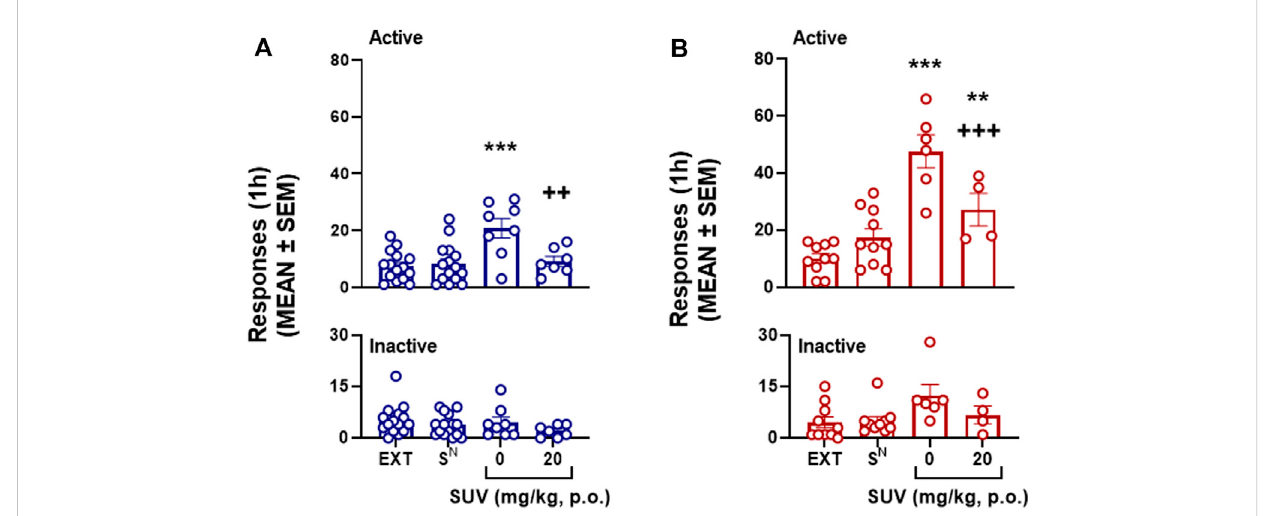
FIGURE 6 Effectofsuvorexantonconditionedreinstatementofoxycodone-seekingbehaviorinmales( n =15, n =7-8perdose) (A) andfemales( n =10, n =4-